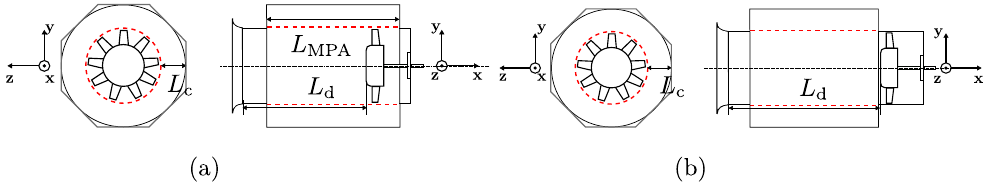
Figure 9. Schematic representation of the MPA duct design (M). Free in fl ow conditions (F) with long (L) as well as short (S) version (with the same length as in reference case); L MPA = 440 mm and indicated cavity length L c , cf. [15]. (a) Short MPA fan duct setup, MFS. (b) Long MPA duct setup,